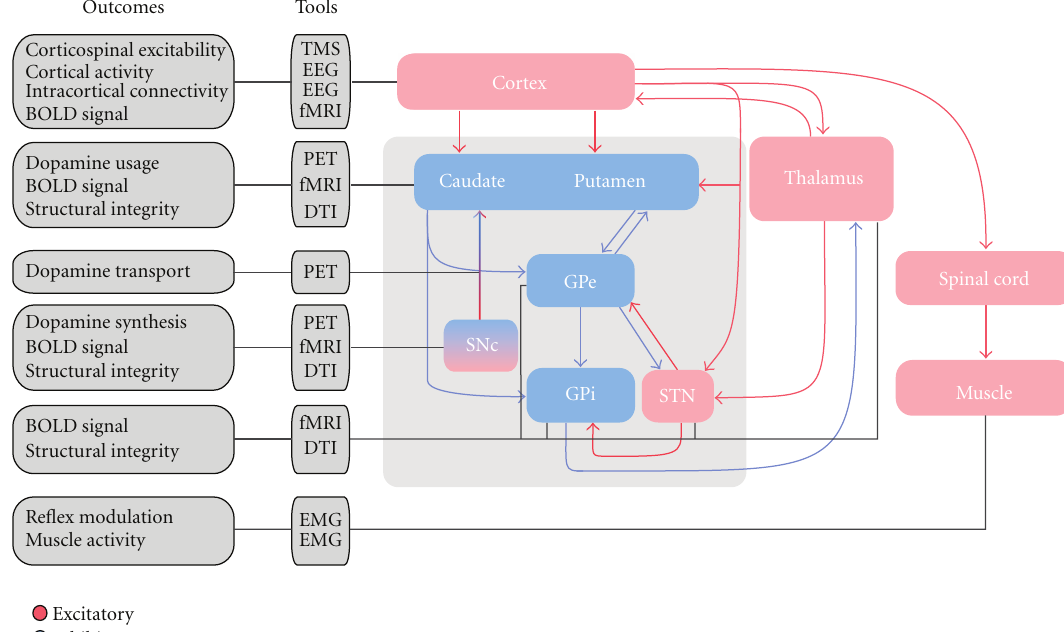
Figure 1: Hypothesized central e ff ects PRE might have in the cortex, basal ganglia, and spinal cord and the tools that can be used to examine these hypothesized changes. TMS, transcranial magnetic stimulation; EEG, electroencephalography; fMRI, functional magnetic resonance imaging; PET: positron emission tomography; DTI: di ff usion tensor imaging; EMG: electromyography; SNc: substantia nigra pars compacta; GPe: external globus pallidus; GPi: internal globus pallidus; STN: subthalamic